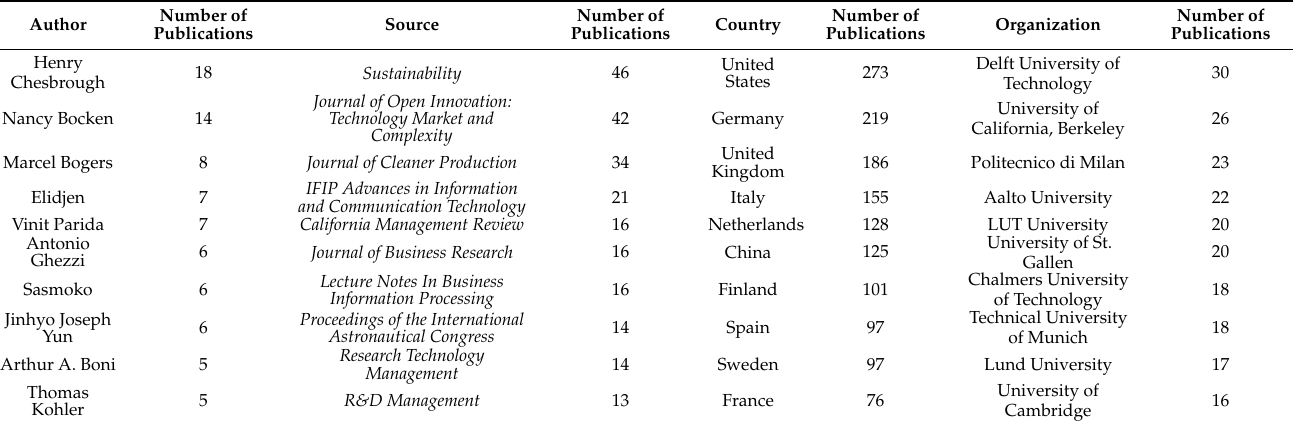
Table 1. Most prolific authors, sources, countries, and organizations in the BM&OI